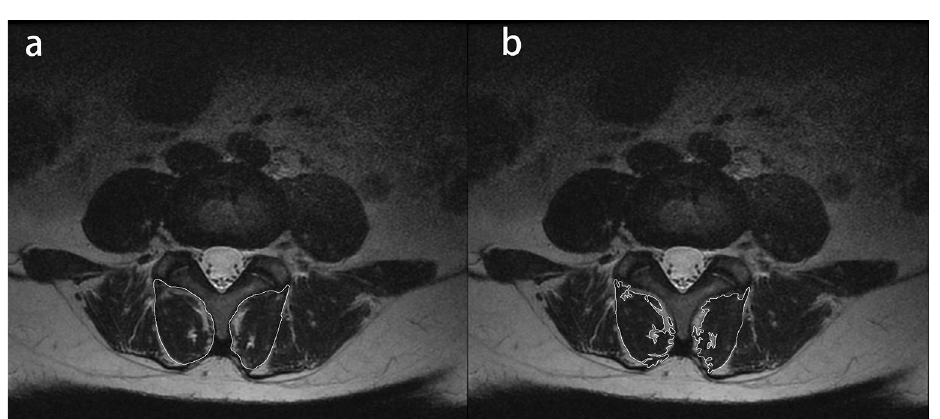
Figure 8. Parameters measured on MRI. ( a ) Total multifidus muscle cross-sectional area (TCSA). ( b ) Fat-free multifidus muscle cross-sectional area